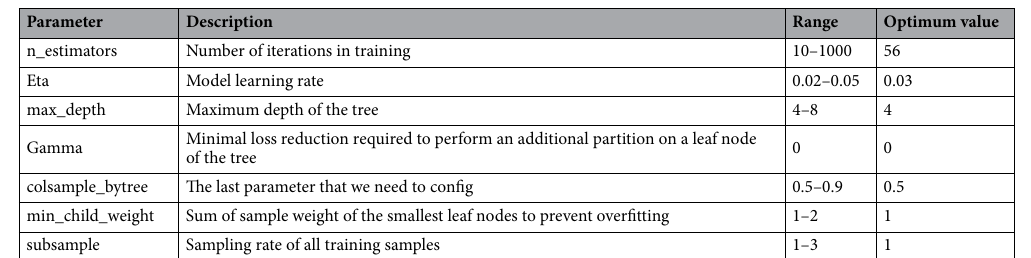
Table 2. Extreme Gradient Boosting regression modeling hyperparameters from the grid search. Optimum value = hyperparameter selected for the improved model (tuning).